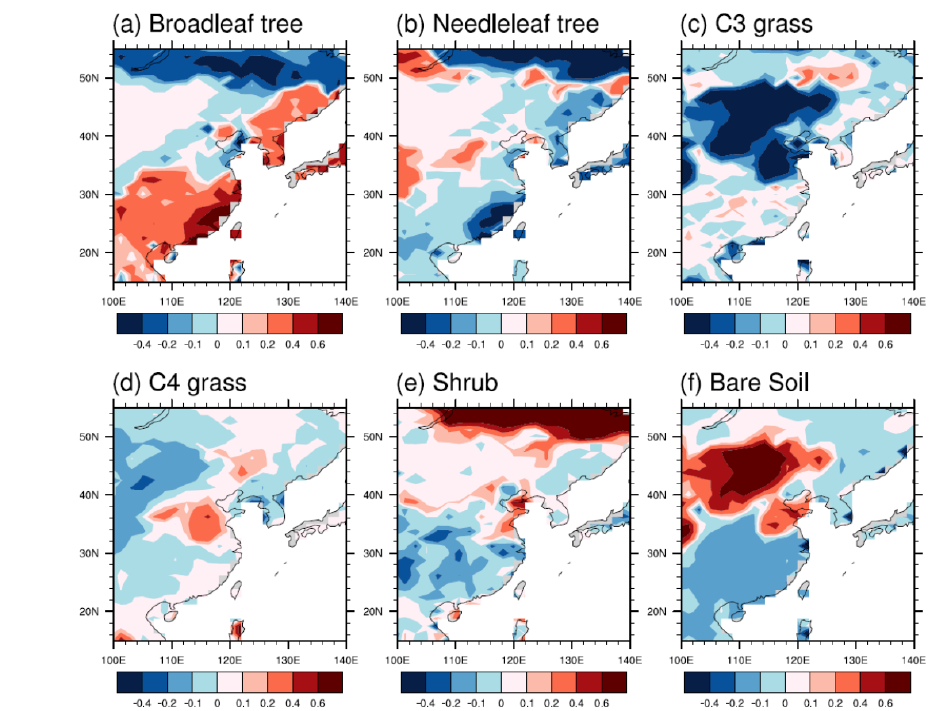
Figure 4. Differences in present-day (1980–2005) fractions of land cover type between HadGEM2-ES and HadGEM2-AO (and HadGEM2- A) over east Asia.